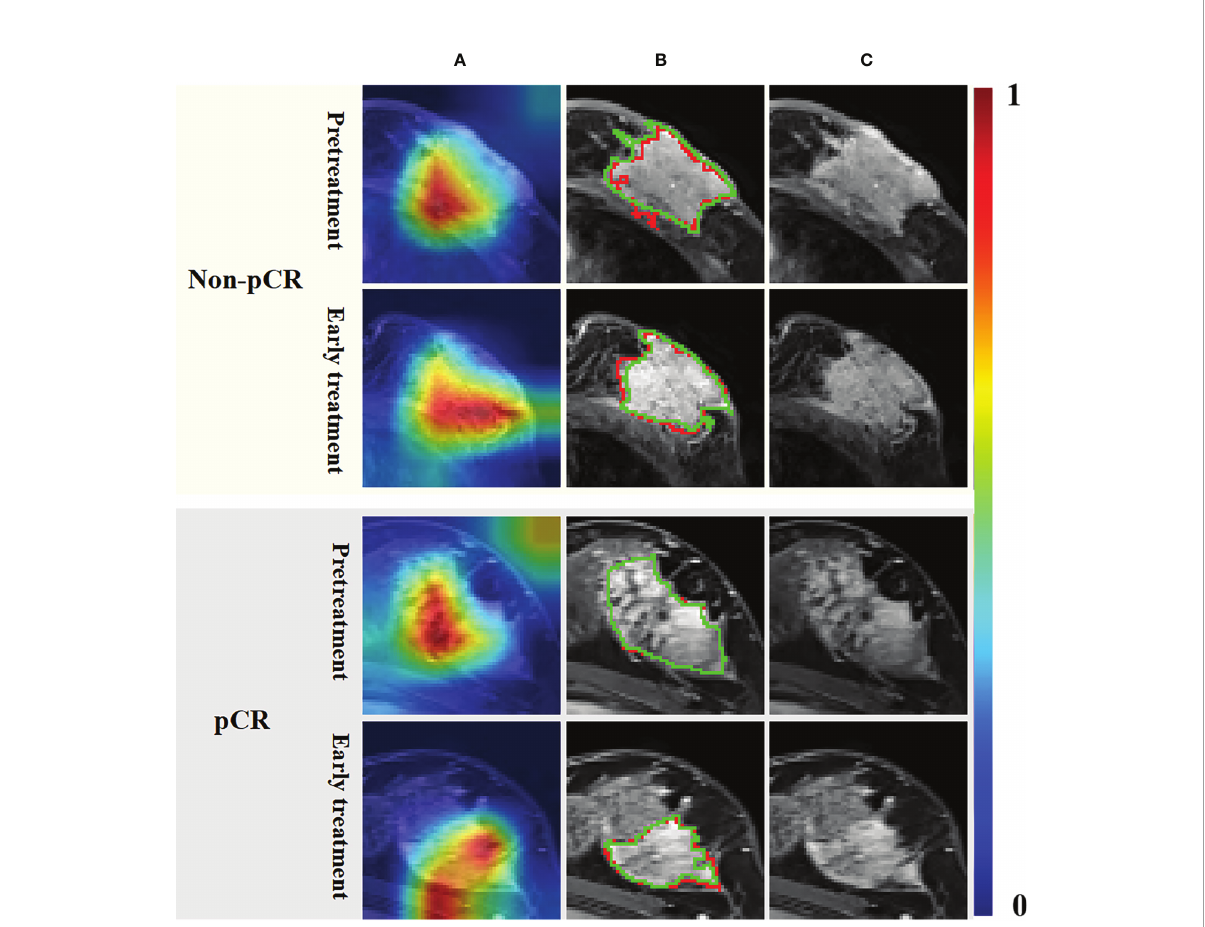
FIGURE 3 Grad-Cam heat maps (A) calculated by the UCtransNet network, segmentation results (B) and DCE-MRI (C) . The red line in the segmentation result represents the prediction result, and the green line represents the ground truth. The red and yellow regions in the heat maps represent areas with higher activation, while the blue and green regions represent lower activation.